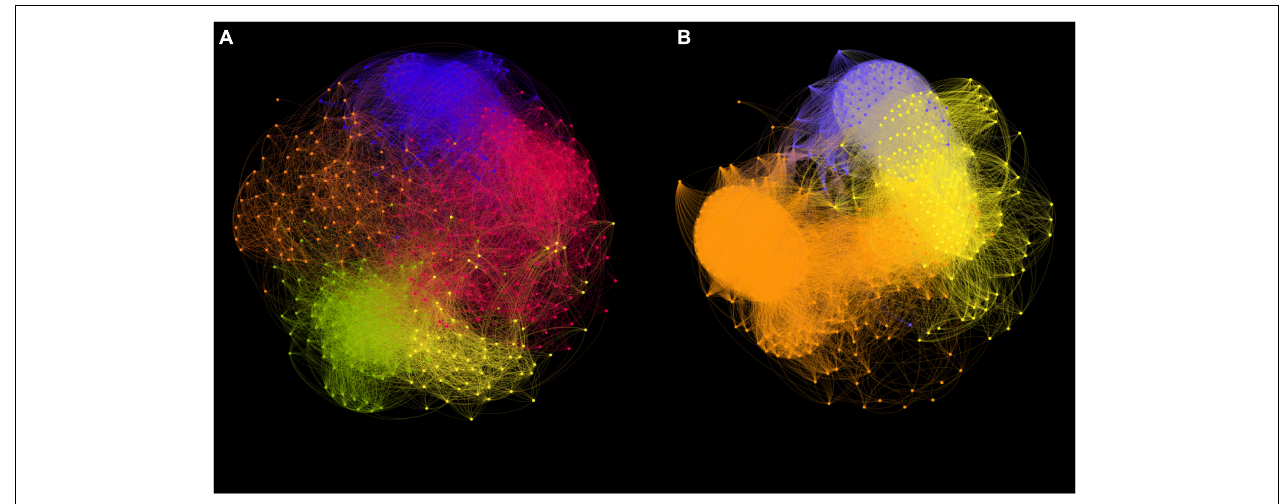
FIGURE 7 | Co-occurrence network analysis of Synechococcus communities based on ASVs at DNA (A) and cDNA (B) levels. Nodes in networks represent ASVs. The modules are represented by different colors. The connections represent Spearman’s significant ( p < 0.05) correlations.